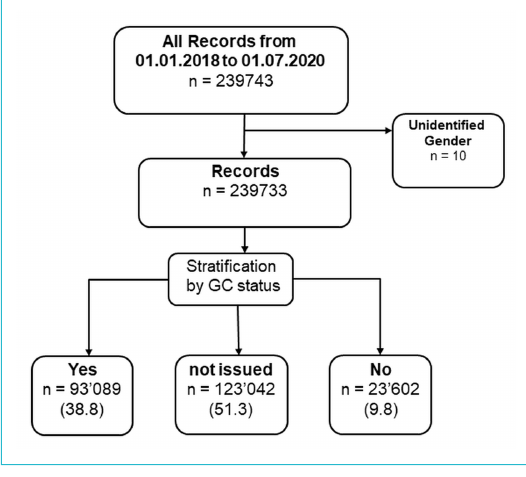
Figure 1: General Consent data processing